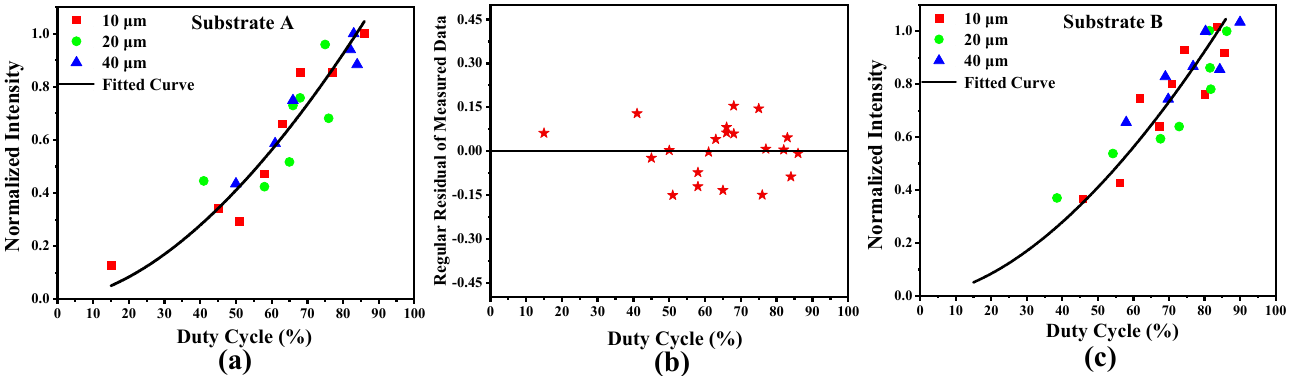
Figure 9. Normalized spectral intensity ( a ) and regular residual ( b ) of substrate A as functions of duty cycle, and the normalized spectral intensity of substrate B ( c ): ■ , ● and ▲ represent the measured discrete data for 10, 20 and 40 μ m laser spots, respectively; the real line denotes the fitted curve; the residual data is represented by ★ .